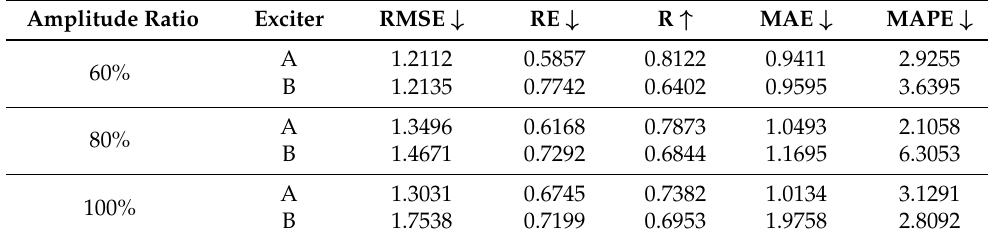
Table 8. Quantitative analysis on the MIMO identification performances. By changing the output dimensions in the network, the load of Exciter A and B can be simultaneously